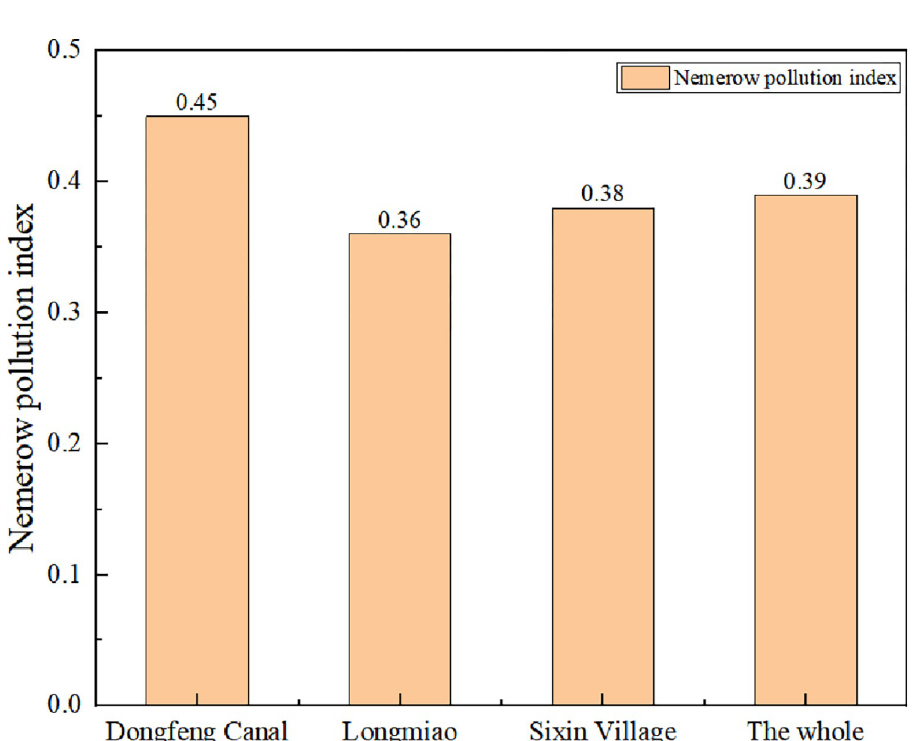
Fig 2. Comparison of Nemerow pollution index of various monitoring sections of Heilongtan Reservoir in 2019.